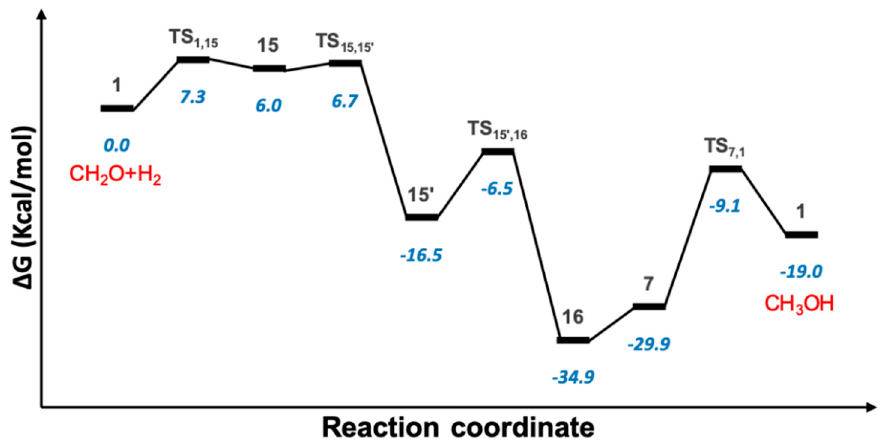
Figure 7. Free energy profile for the hydrogenation of formaldehyde to methanol catalyzed by 1 (Cycle 3). Solvent corrected relative free energies are shown in italic.